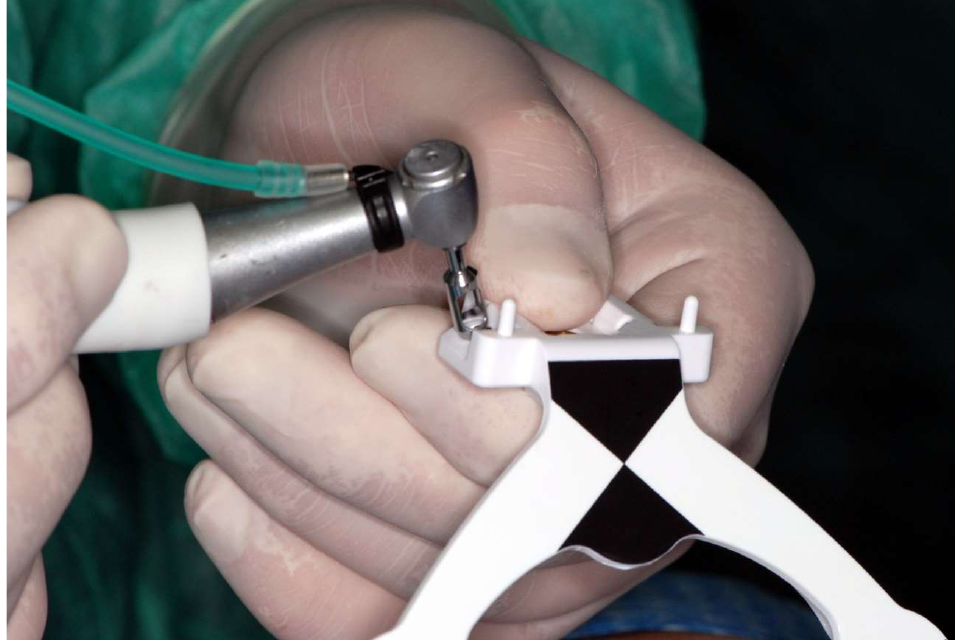
Figure 2. Calibrating the soft tissue punch during operation- with this procedure, the navigation system precisely locates each surgical instrument in 3D.